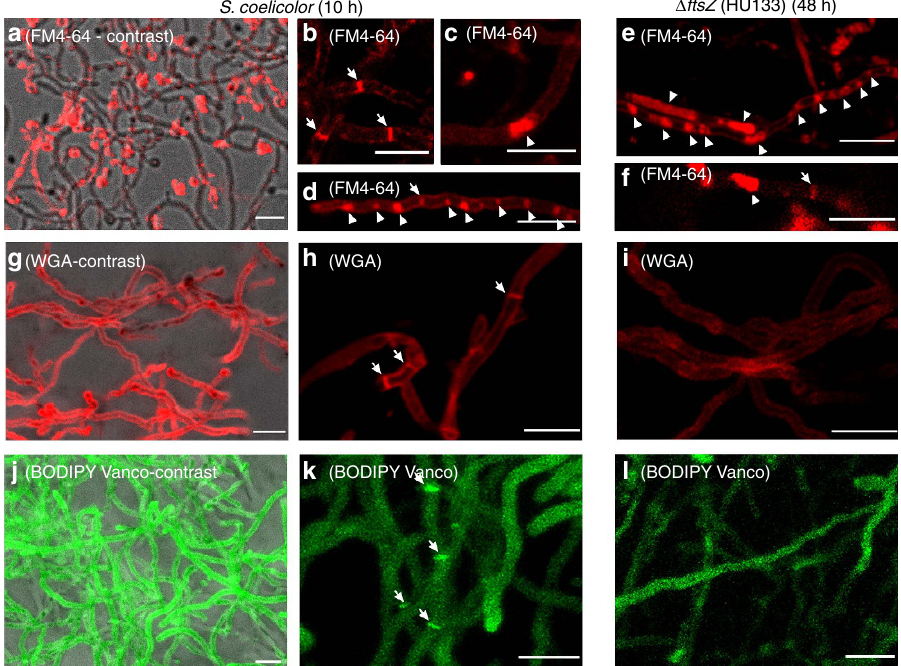
Figure 6 | Membrane and cell wall staining of S. coelicolor and its ftsZ mutant HU133. ( a – f ) FM4-64 staining (membranes). ( g – i ) WGA staining (cell wall). ( j – l ) BODIPY-vancomycin staining (nascent peptidoglycan). Fluorescent images in a , g and j correspond to the maximum projection 10- m m series overlaid with their respective phase-contrast images, showing 100% of the stained hyphae. Arrows indicate cross-membranes and cross-cell walls. Arrowheads indicate membrane cellular segments filled with membrane vesicles. Scale bars, 4 m